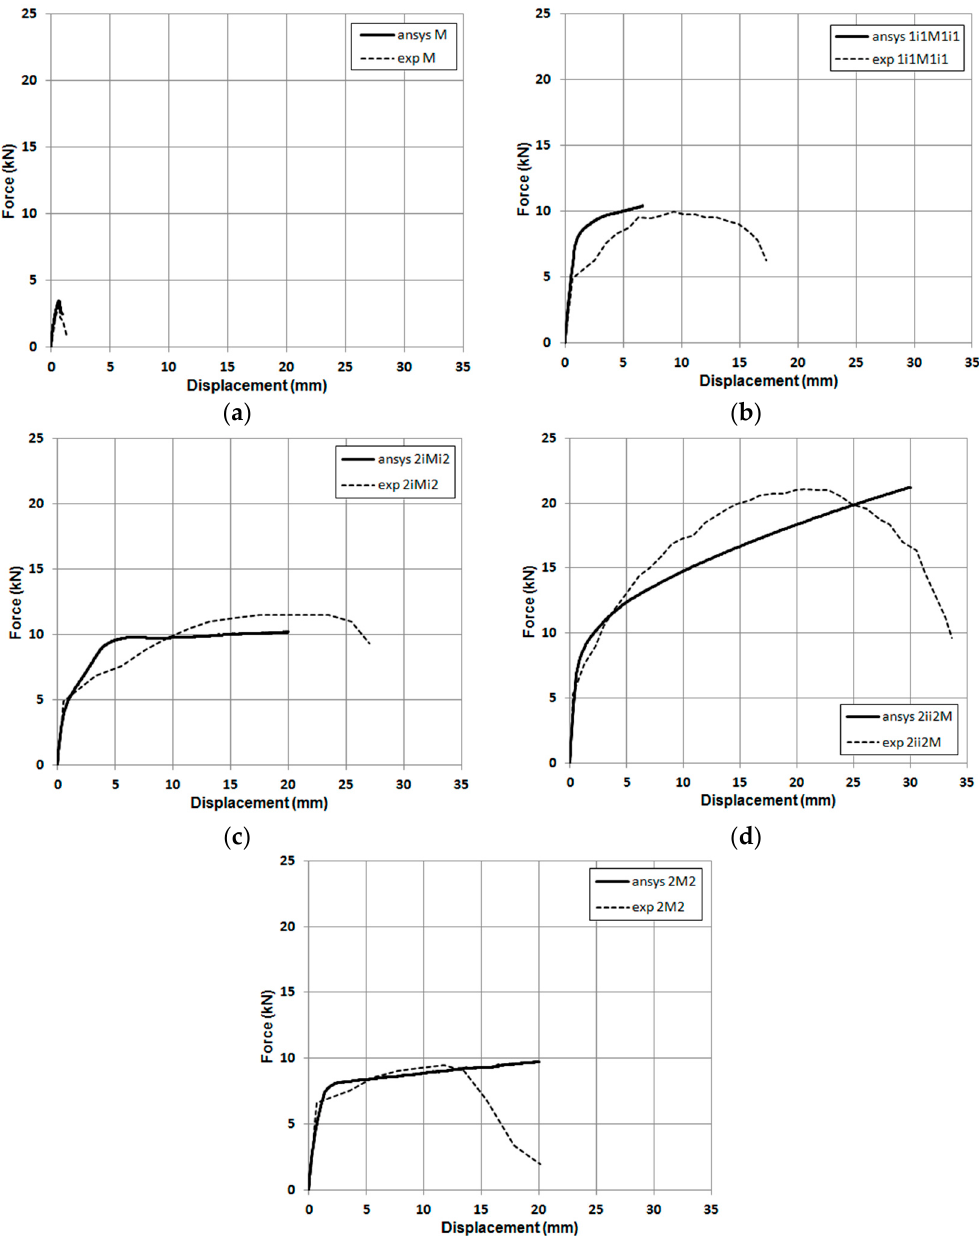
Figure 14. Force–displacement envelope curves for the experimental versus numerical results: ( a ) specimen M, ( b ), specimen 1i1M1i1, ( c ) specimen 2iMi2, ( d ) specimen 2ii2M, ( e ) specimen 2M2.